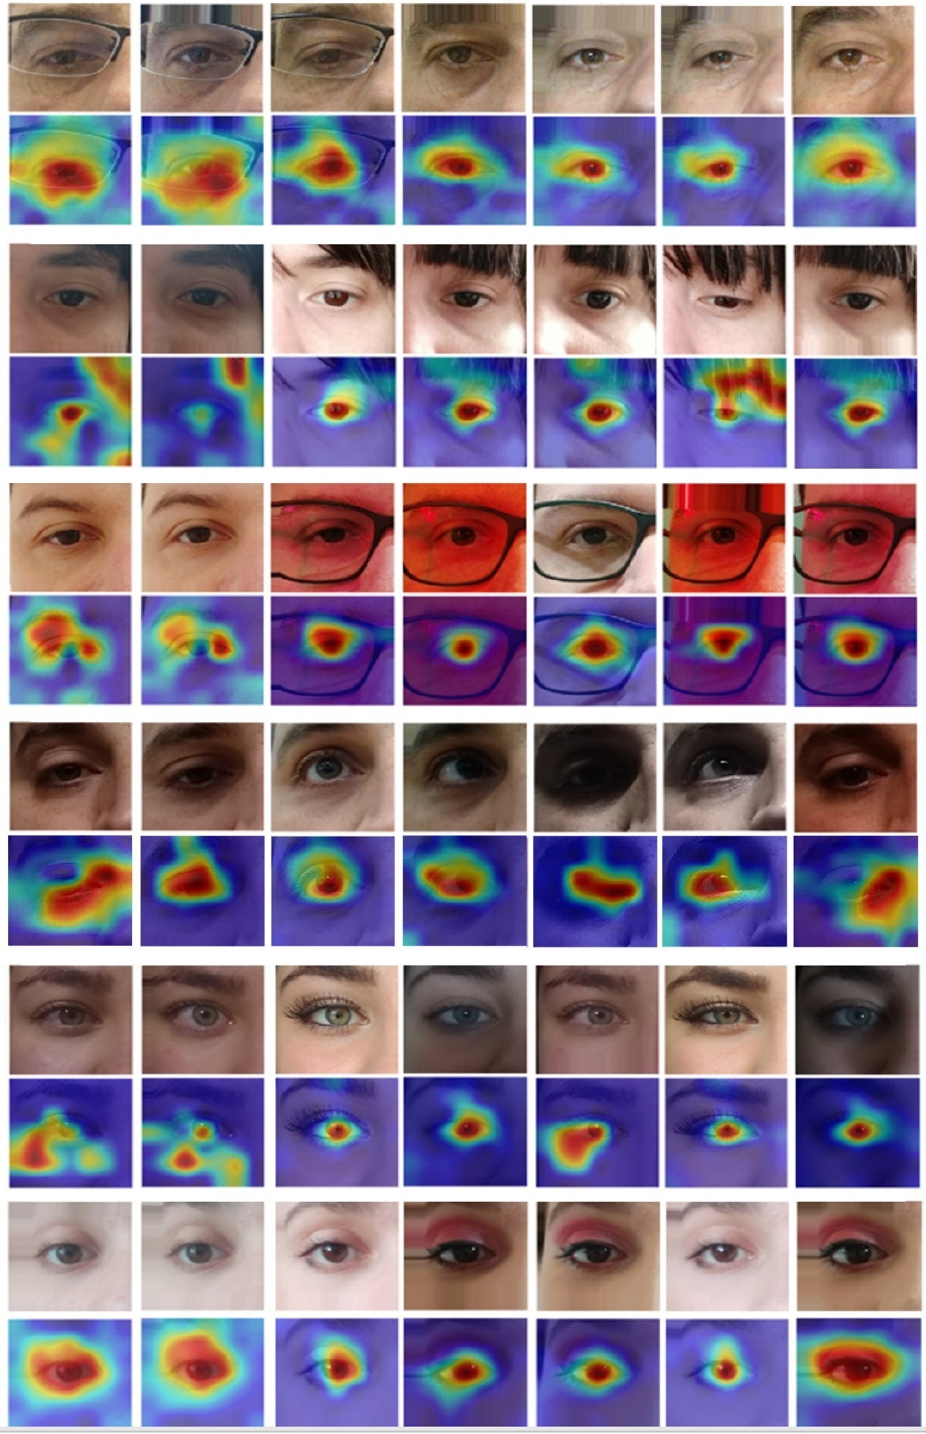
Figure 16. The Grad-CAM heatmaps of the LDA-CNN model for selected images were selected from the UFPR dataset under various variations that occur in the wild environment: different poses, gazes, with/without makeup, and partial occlusions (hair and glasses).